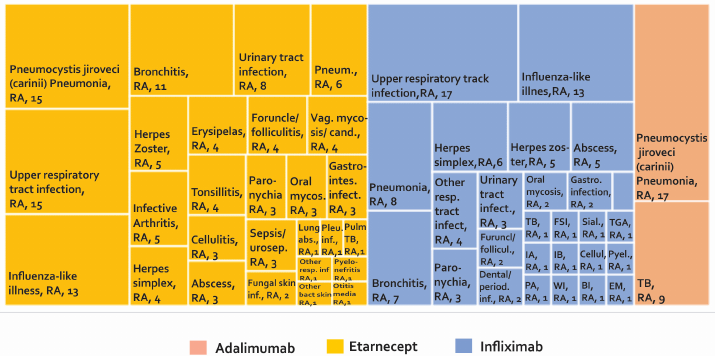
Figure 6. Adversebiotherapeuticeventsinrheumaticdiseasespresentedincase-controlstudies [104–107]. Figure 6. Adverse biotherapeutic events in rheumatic diseases presented in case-control studies [104– 107] . As can be seen in Figure 6 and supplementary Table S4, 80 AE have been reported in case-control studies. The most frequently reported AE are upper respiratory infection with infliximab in 17 cases and etanercept in 15 cases. Likewise, AE Pneumocystis jiroveci ( carinii ) pneumonia was reported in 17 cases with adalimumab and 15 cases with etanercept, followed by influenza-like illness in 13 cases with both infliximab and etanercept.